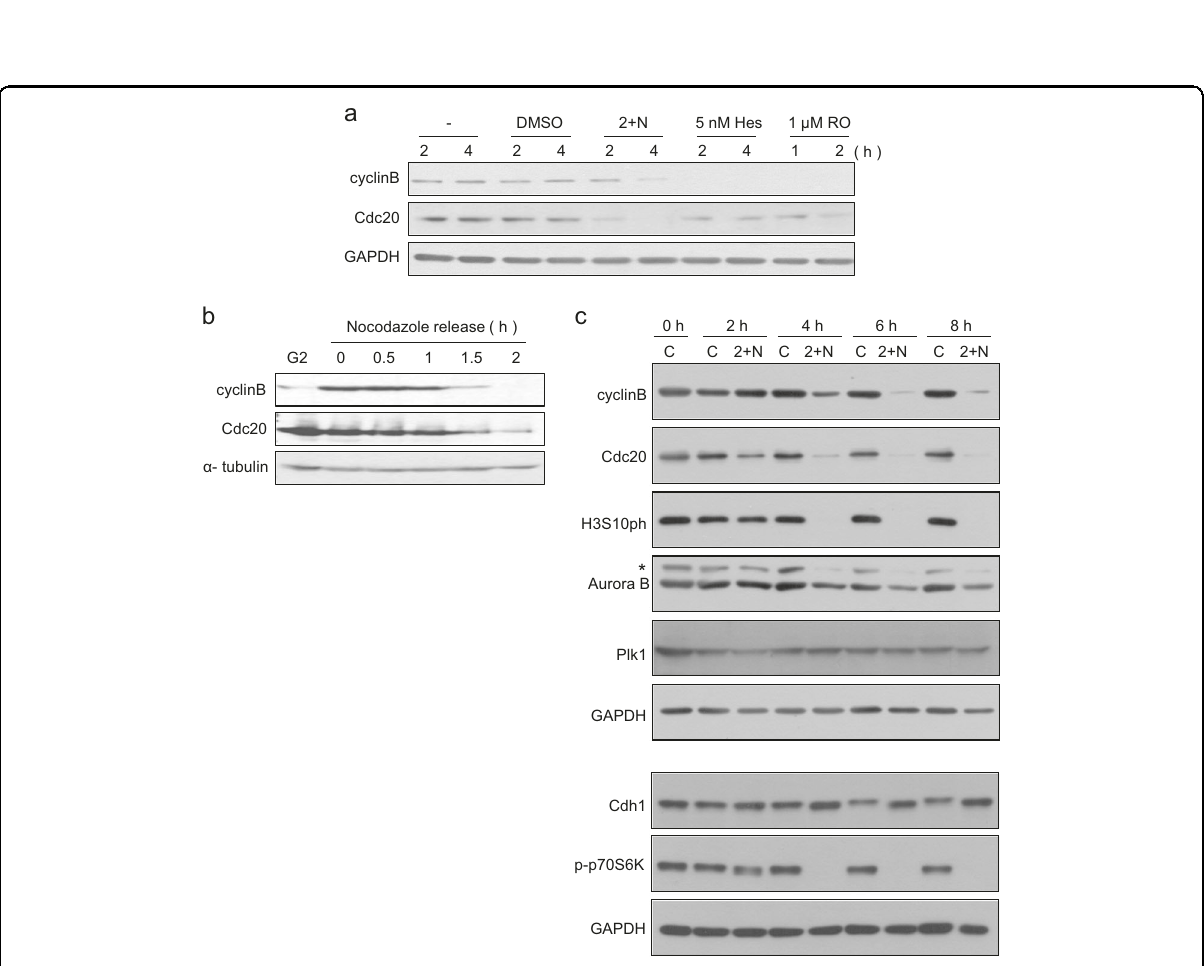
Fig. 3 Decrease in Cdc20 before cyclin B in mitotic slippage following ATP depletion. a Comparison of the protein levels during mitotic slippage induced by 5 nM hesperadin (Hes), 1 μ M RO3306 (RO), or co-treatment with 2-DG and NaN 3 (2 + N). Cells arrested in mitosis by nocodazole treatment for 16 h were treated with each drug for the indicated times. Cell lysates from the indicated times after drug treatment were subjected to western blot analysis using antibodies for cyclin B, Cdc20, and GAPDH (loading control). b Cells arrested in mitosis for 16 h were released. Cell lysates from the indicated times after release from nocodazole were subjected to western blot analysis using antibodies for cyclin B, Cdc20 and α -tubulin (loading control). c Mitotic arrested cell lysates from the indicated times after treatment with/without 2-DG and NaN 3 (2 + N) were subjected to western blot analysis using antibodies for cyclin B, Cdc20, phospho-Histone H3Ser10, Aurora B, Plk1, Cdh1, phospho-p70S6 Kinase, and GAPDH (loading control). *non-speci fi c band